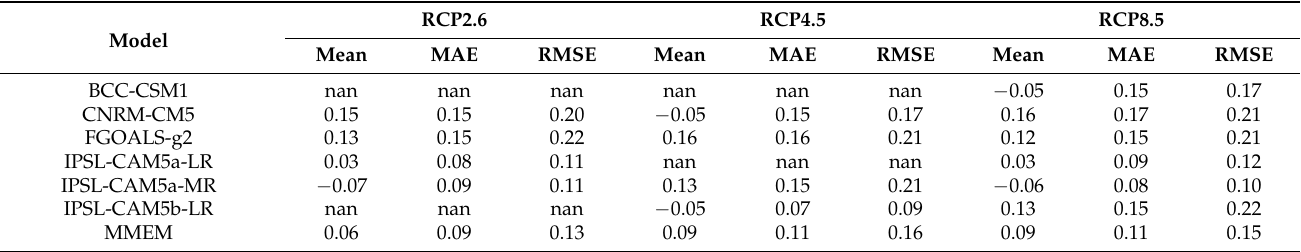
Table 3. Sea ice albedo difference statistics between CMIP5 and APP-x in the 70 ◦ N range from 2006 to 2020.